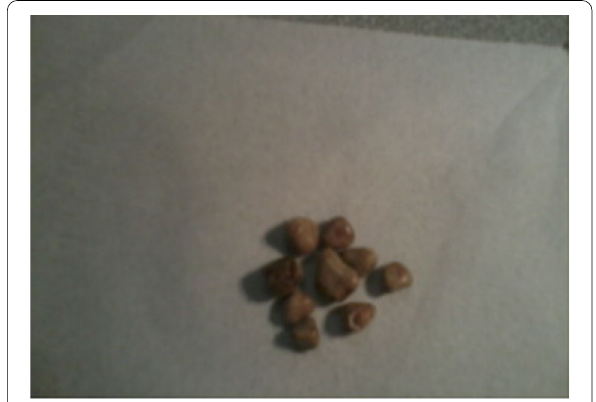
Fig. 2 Infrared spectrum of calcium